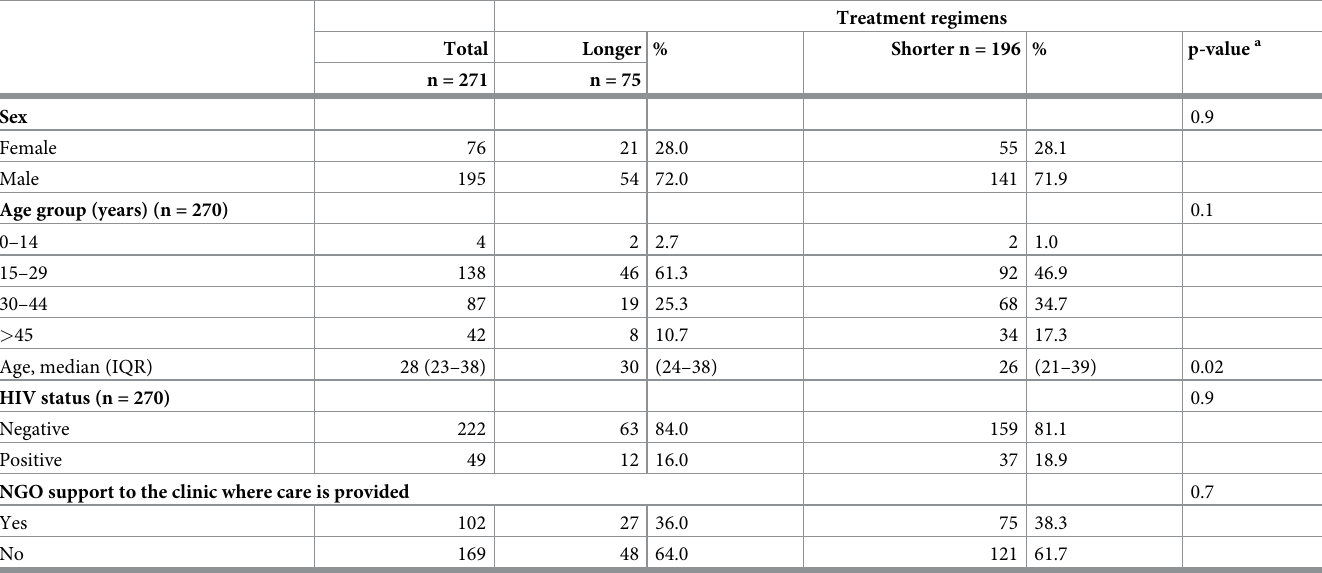
Table 1. Characteristics among patients who started MDR-TB treatment between 2016 and